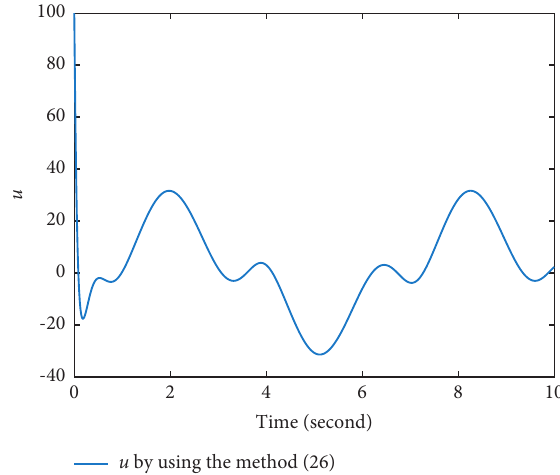
Figure 3: Time response trajectory of controller u by using method (26).